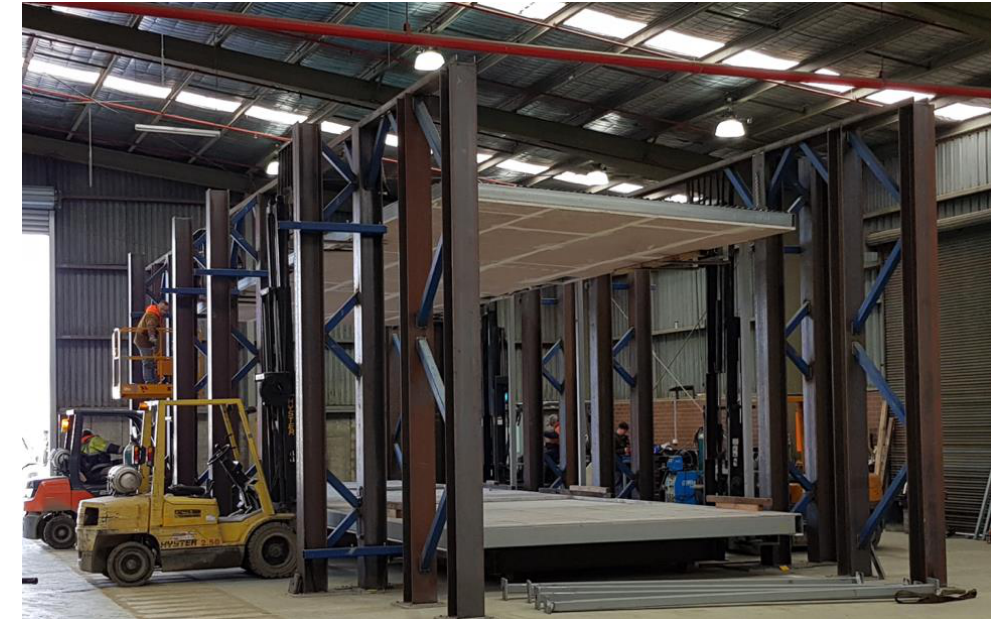
Figure 8. Forklifts handling partly finished modules within an offsite manufacturing facility.